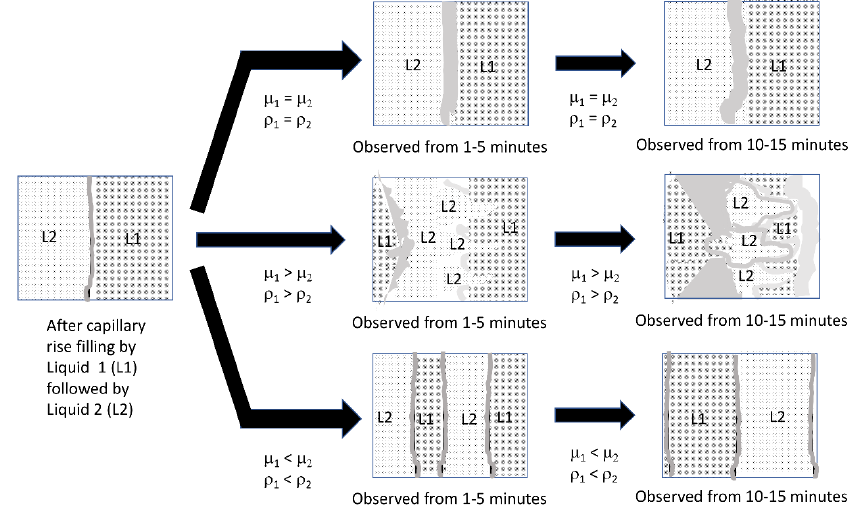
Figure 13. Characterization of liquid front movements in the visualization experiments, where (1) is the initial liquid loaded into the gauze pad via capillary action, and (2) is the second liquid applied via capillary action. Each liquid is added at 300 µ L and the total capacity of the gauze pad for liquid is 600 μ L.